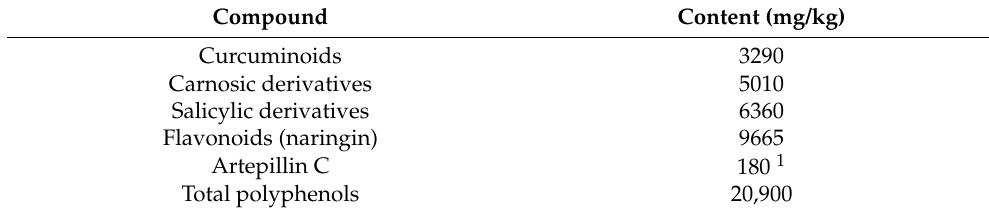
Table 8. Composition of Phyto